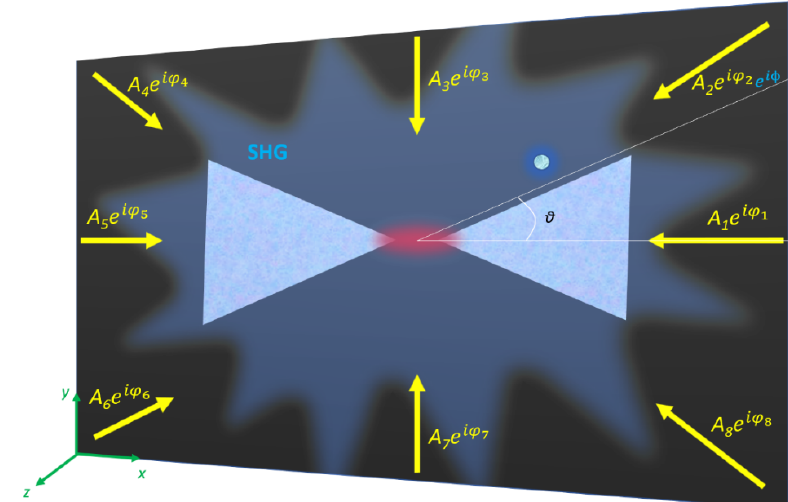
Figure 1. Schematic sketch of the proposed structure. The dielectric bow-tie antenna is illuminated with different optimized plane waves. A fundamental mode with enhanced field in the gap region is therefore excited. The different excited modes are responsible for different second-harmonic generation (SHG) signals. The generic perturbation is modeled as an extra phase term ϕ in the incident field A 2 e jϕ2 .